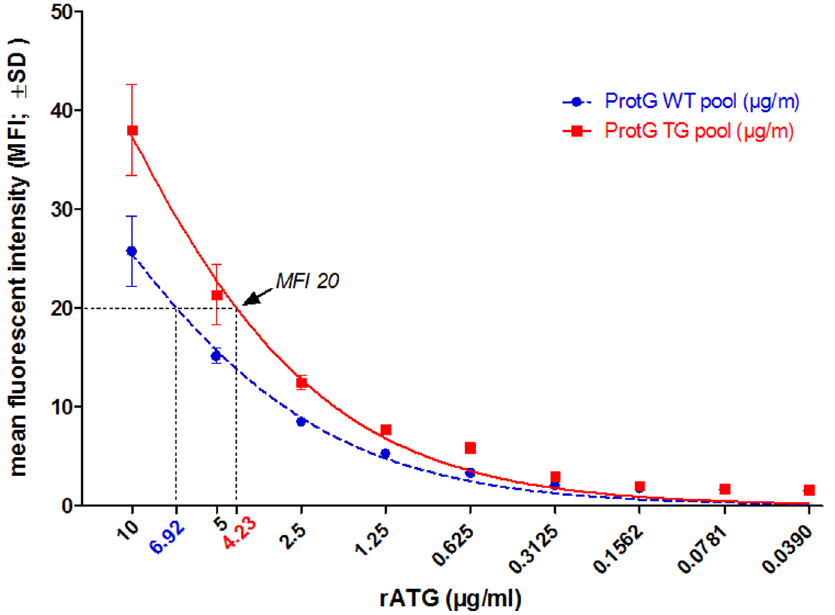
Figure 3. Binding of Protein-G purified, pooled Tg and wt IgG antibodies to Jurkat cells. The binding capacity of the Tg IgG analyzed by flow cytometry in a concentration range from 10 - 0.039 m g/ml was higher at all concentrations compared to their wt controls. The non-linear regression analysis indicated that binding activities of MFI 20 was achieved at concentration of 6.92 m g/ml or 4.23 m g/ml, in cases of wt or Tg preparations, respectively, indicating that Tg IgG binding was more than 60% higher than its wt